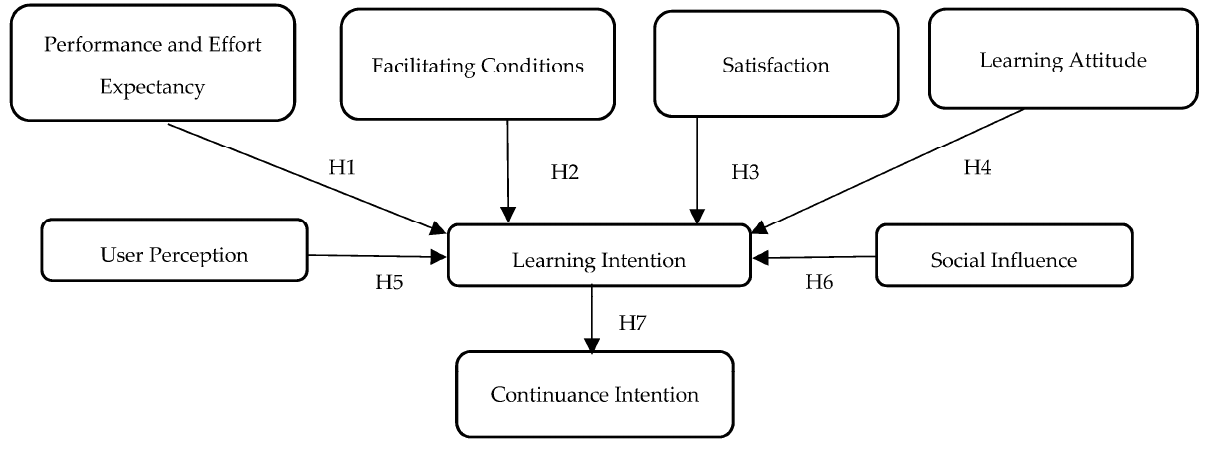
Figure 4. Theoretical research framework.